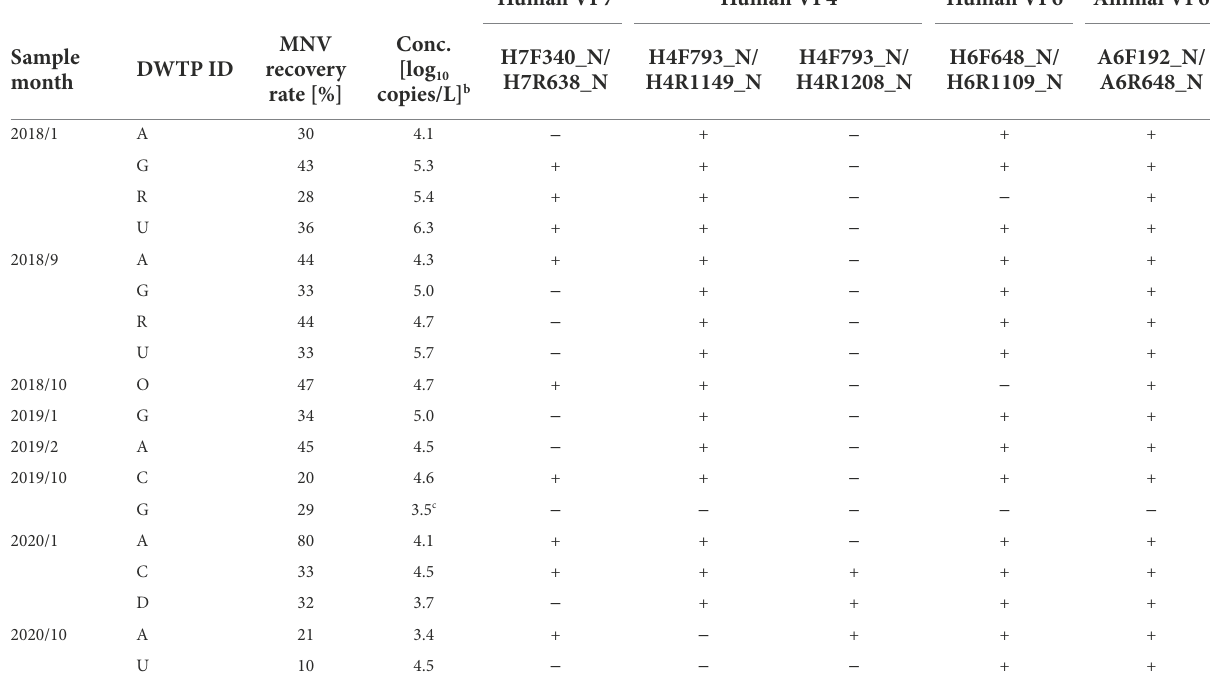
TABLE 3 Sensitivity of developed nested PCR assays evaluated using Sample Set 2.